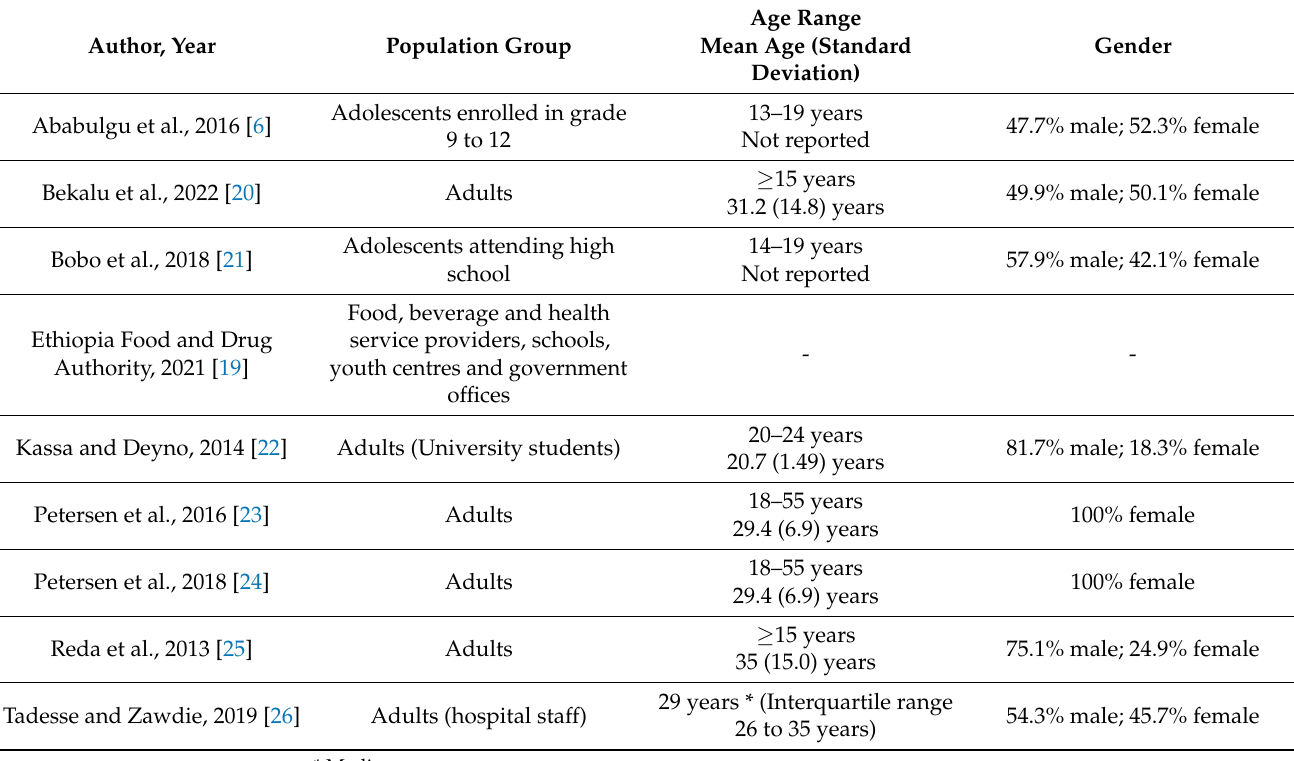
Table 3. Study population